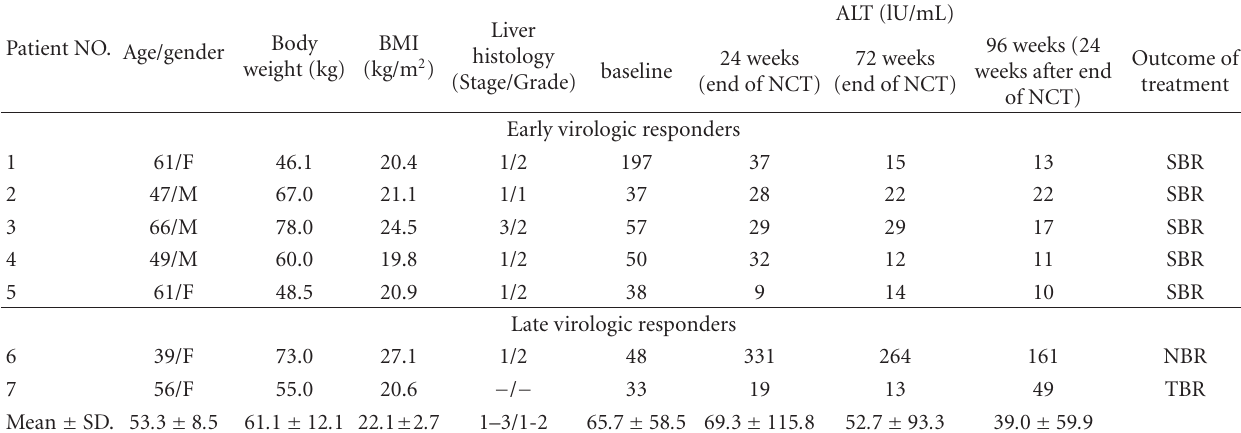
Table 1: Characteristics of chronic hepatitis C with high viral load, serotype-1 (genotype 1b), and wild or intermediate type in ISDR before, during, and after RBV plus PEG-IFN-alpha 2b using an “induction” therapy with cyclic and periodic interferon treatment (CPIT); novel combination treatment